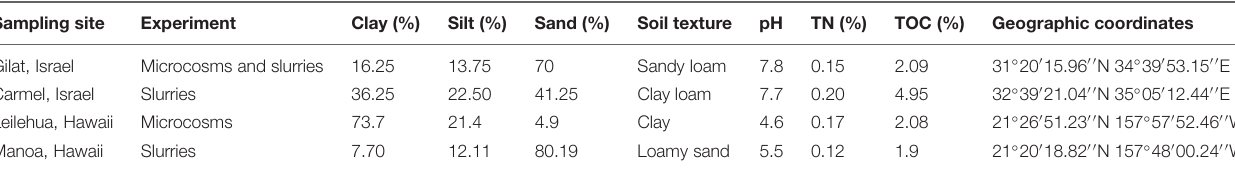
TABLE 1 | Characteristics of soils used in this